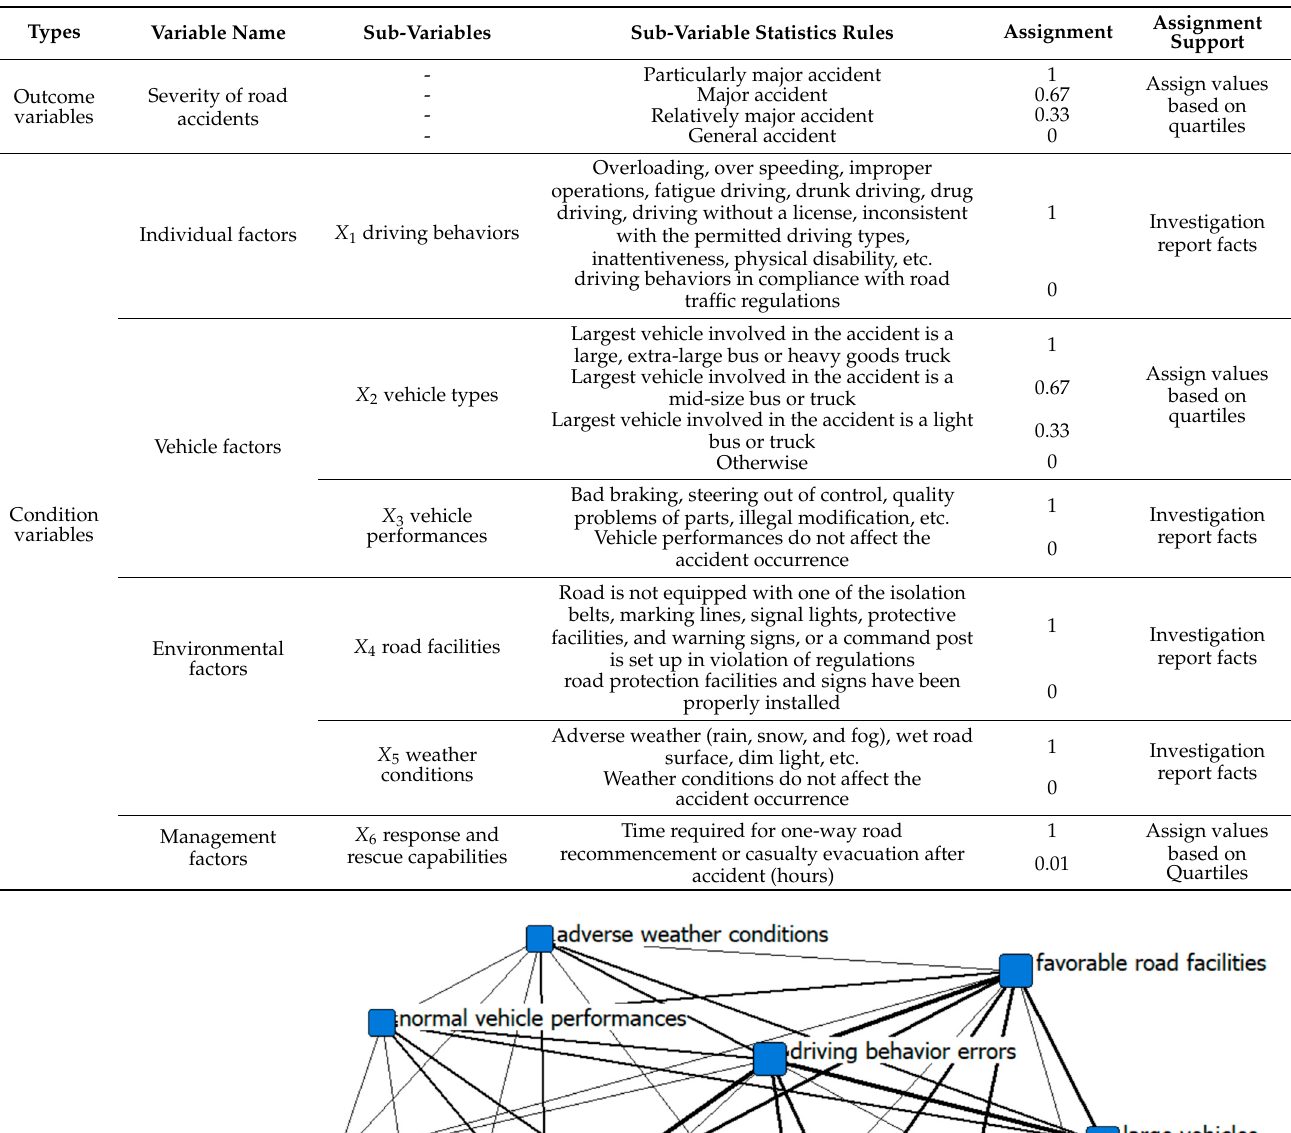
Table 1. The operational definition and assignment of variables.